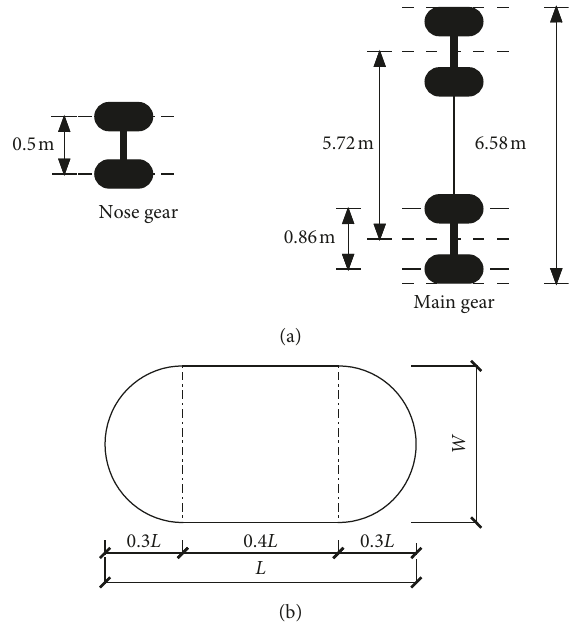
Figure 7: Wheel configuration of the Boeing 737–800 aircraft.